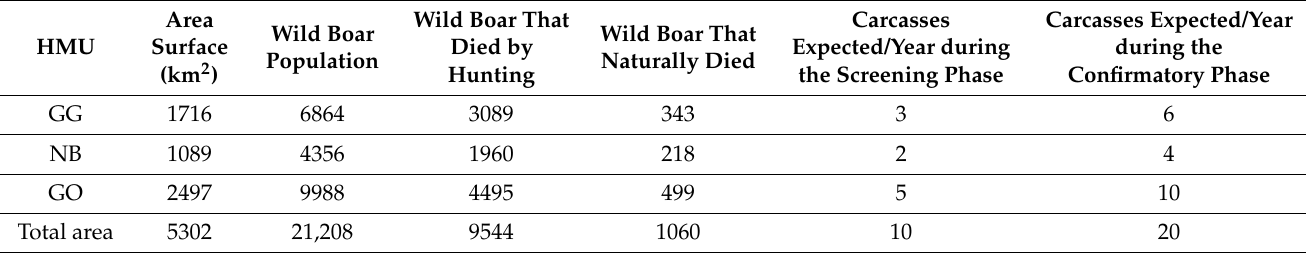
Table 4. Data estimated by the WBC-Counter tool when applying the first approach based on the wild boar density.